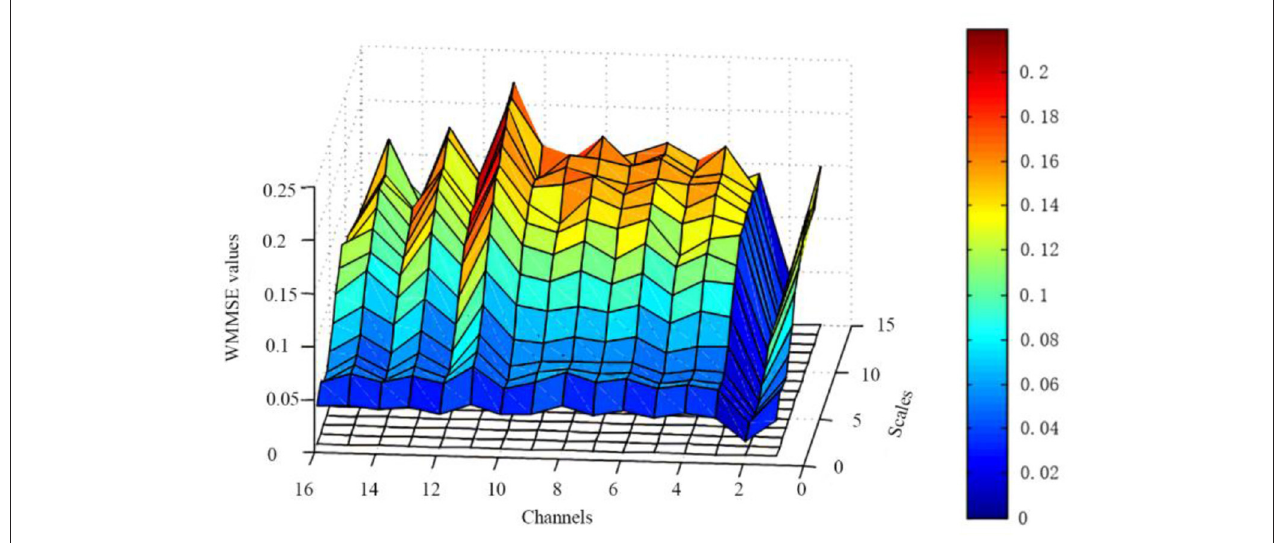
FIGURE 4 | Changes of WMMSE values pre- and post- NFT. The x-axis represents 16 channels, the y-axis represents 15 scales, and the z-axis represents WMMSE values.